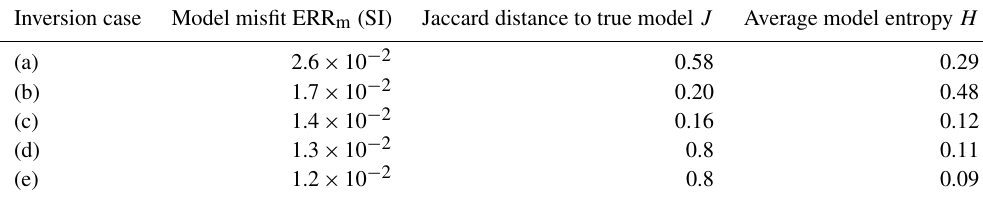
Table 3. Metrics calculated for the assessment of inverted models for cases